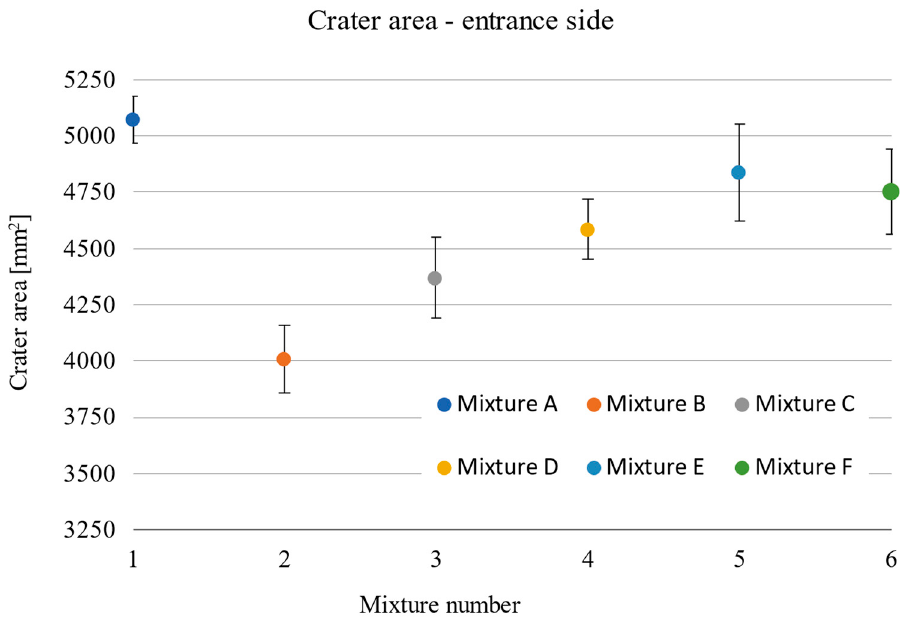
Figure 11. Size of the entrance crater area by individual mixtures.